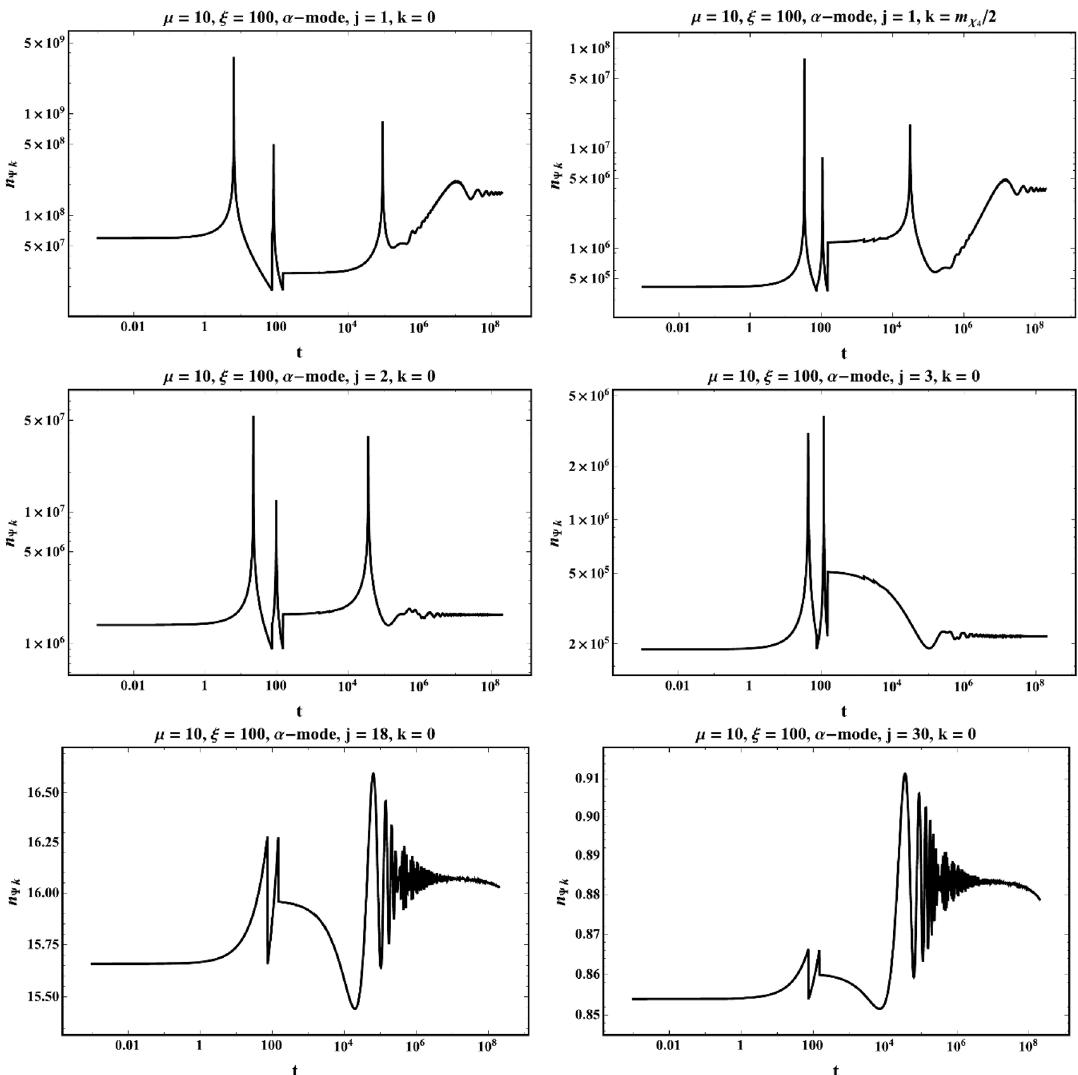
Figure 8 . The time evolution of number density for some of the (cid:11) -preheat modes for various values of k for (cid:22) = 10 and (cid:24) =